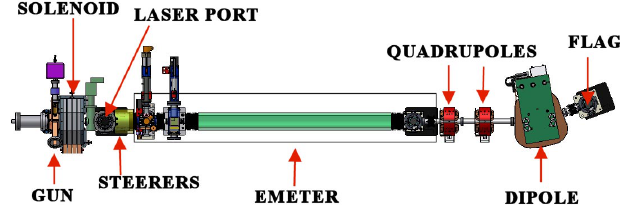
FIG. 2. (Color) Schematic layout of the experiment. Emeter is the abbreviation of the emittance